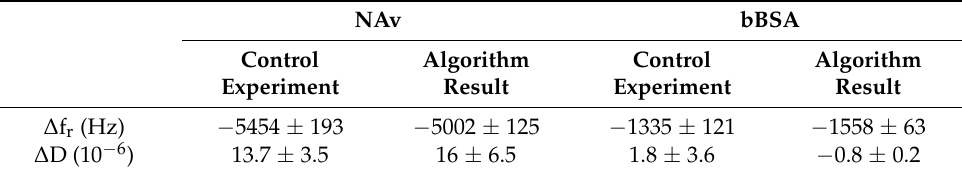
Table 1. Comparison of resonance frequency and dissipation shifts measured during a control experiment (see S4 in the Supporting Information) and the results provided by the algorithm in the experiment showed in Figure 5 under strong influence of external factors. Control experiment was carried out under stable temperature (23 ◦ C) and flow rate (20 µ L/min). Data shown in the table represent average and standard deviation calculated from 4 HFF-QCMD sensors integrated in a column of the MQCM device. NAv bBSA Control Algorithm Control Algorithm Experiment Result Experiment Result ∆ f r (Hz) − 5454 ± 193 − 5002 ± 125 − 1335 ± 121 − 1558 ± 63 ∆ D (10 − 6